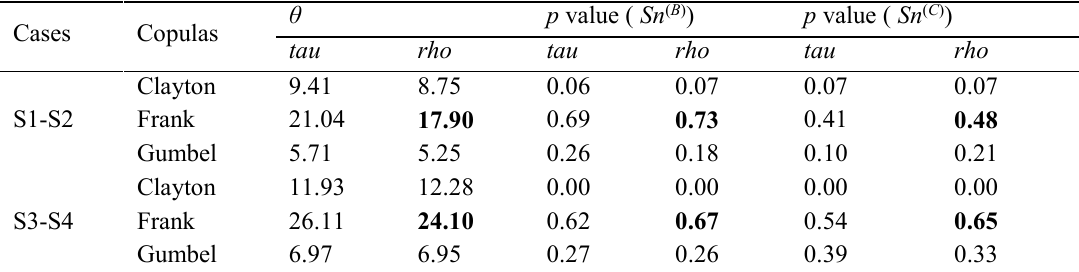
Table 1 Goodness-of-fit tests of different estimated copulas.